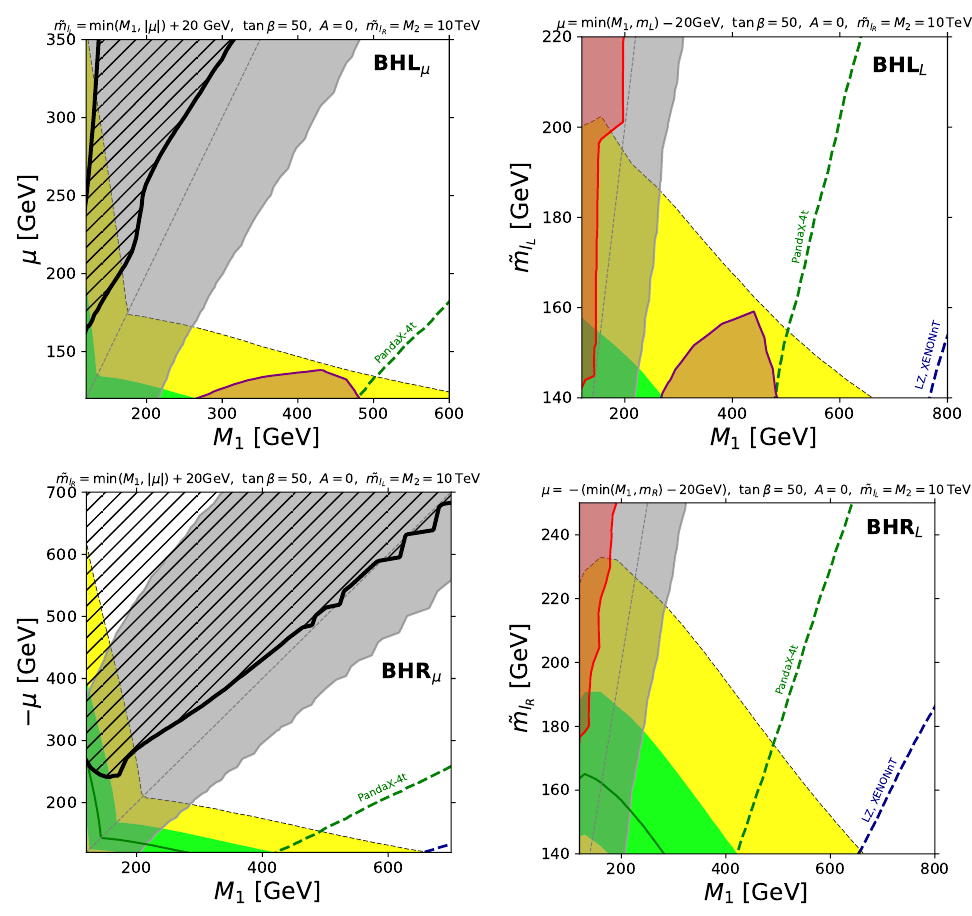
Figure 3 . Results for MSSM BHL µ (upper left), BHL L (upper right), BHR µ (lower left) and BHR L (lower right) planes. Region of parameter space allowed by the latest a µ experimental results [4] is depicted with green and yellow bands, corresponding to one and two sigma agree- ment respectively. Hatched region is excluded by dark matter abundance criterion. Purple and red shaded regions are excluded by LHC constraints. Light grey shaded area is excluded by Xenon1T experiment. Expected exclusion range by future DDMD experiments is also shown with appropri- ately labelled